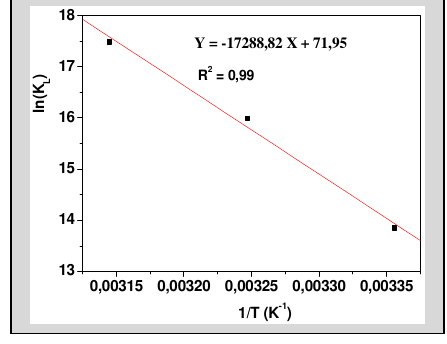
Fig. 11. Graphical representation of equation: ln (K